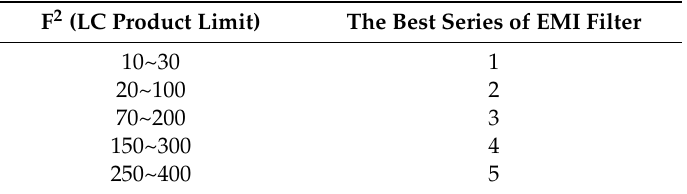
Table 2. Best stages of electromagnetic interference (EMI) filters.